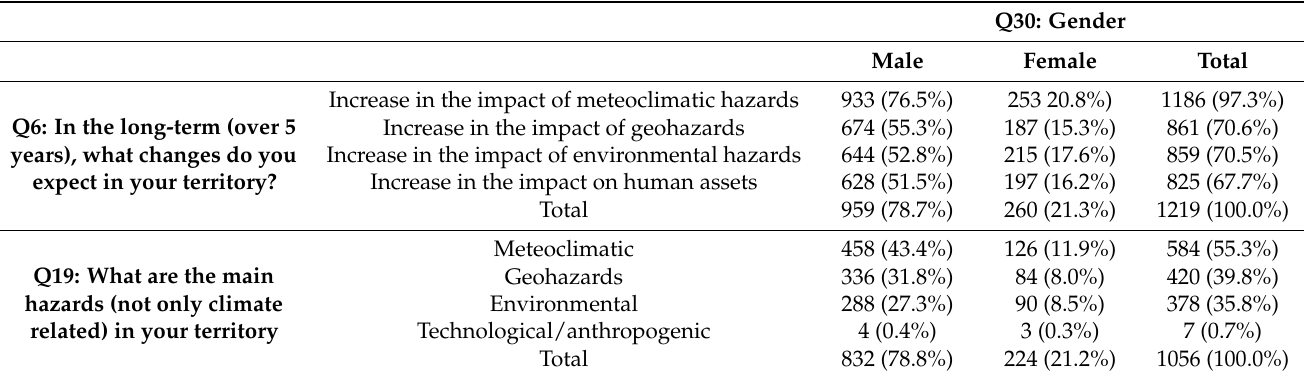
Table 7. Cross table of Q6 and Q30, and Q19 and Q30 with frequencies (percentages) of the answers.